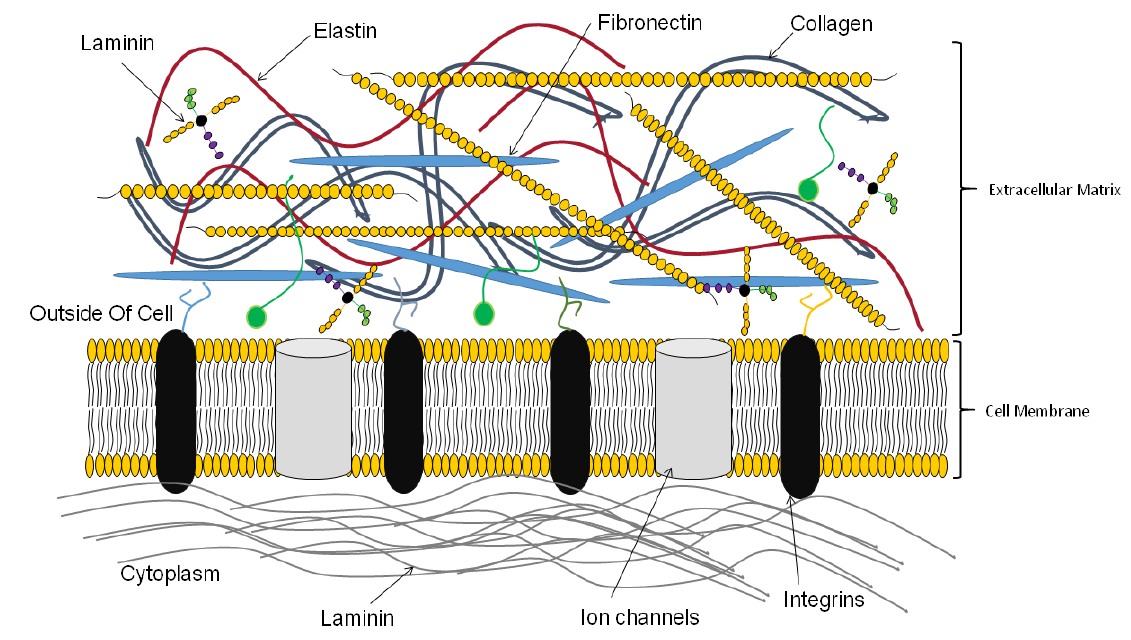
Figure 3. The extracellular matrix.